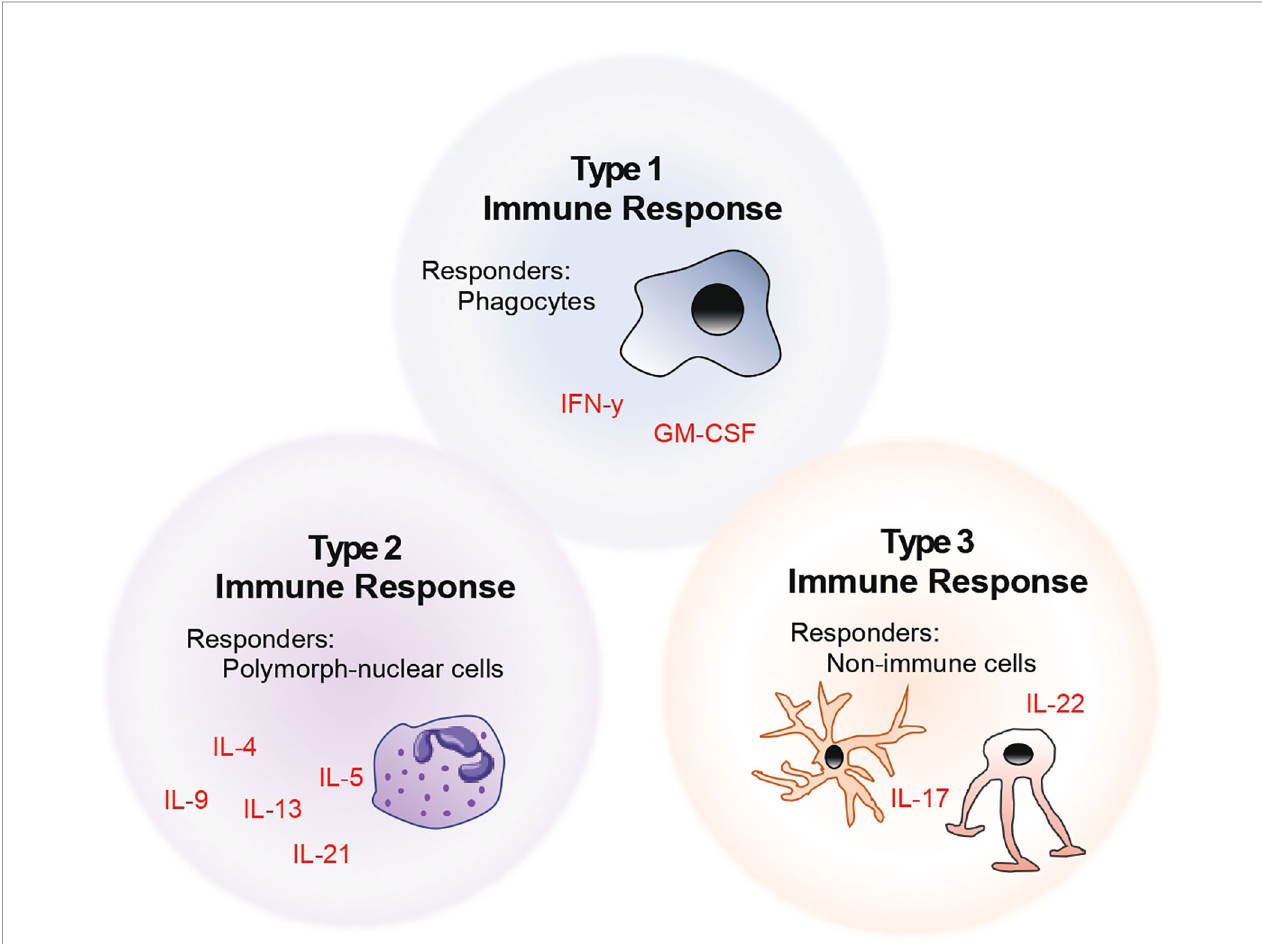
FIGURE 1 | Model of helper T cell classi fi cation by considering the role of helper T cells in the context of their target and effector